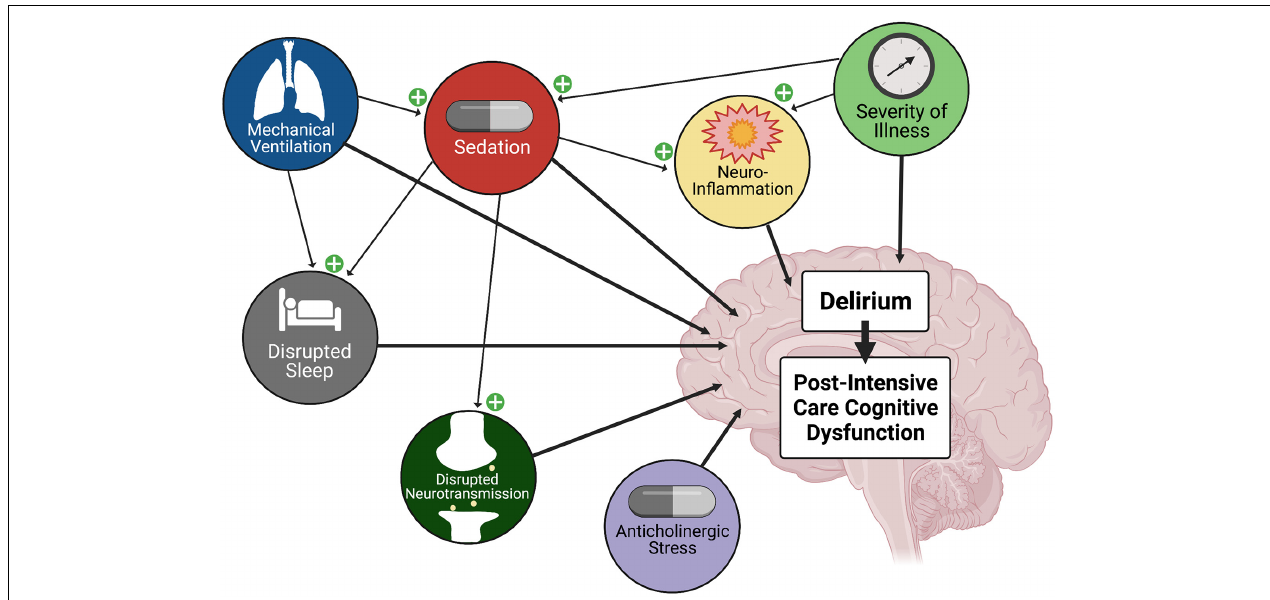
FIGURE 2 | Factors Contributing to Delirium and Post-Intensive Care Cognitive Dysfunction. ICU delirium is multi-factorial in nature, and is associated with post-intensive care cognitive dysfunction. Mechanical ventilation, severity of illness, and anticholinergic burden are linked, and importantly, sedatives have been shown to disrupt sleep/wake cycles. In animal models, sedatives and opioid analgesics have been linked to neuroinflammation and altered connectivity and neurotransmission. Thus, treatment with sedatives and opioid analgesics has an integral role in the development of delirium and post-intensive care cognitive